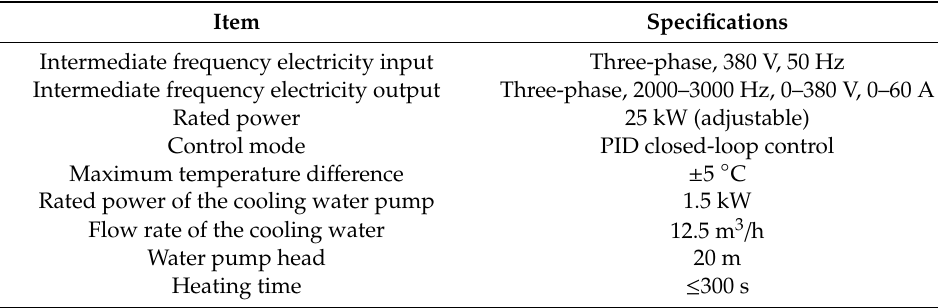
Table 3. Specifications of the intermediate frequency induction furnace.